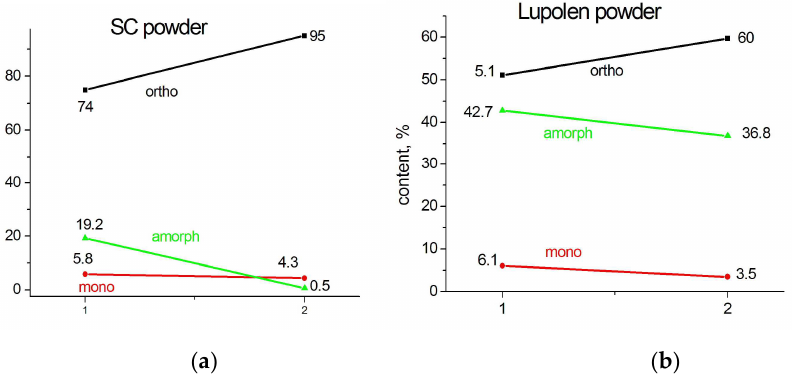
Figure 5. The change in phase composition of SC ( a ) and Lupolen ( b ) individual particles (1) after the heating them from 300 K up to 370 K and quickly cooling them back to 300 K (2).